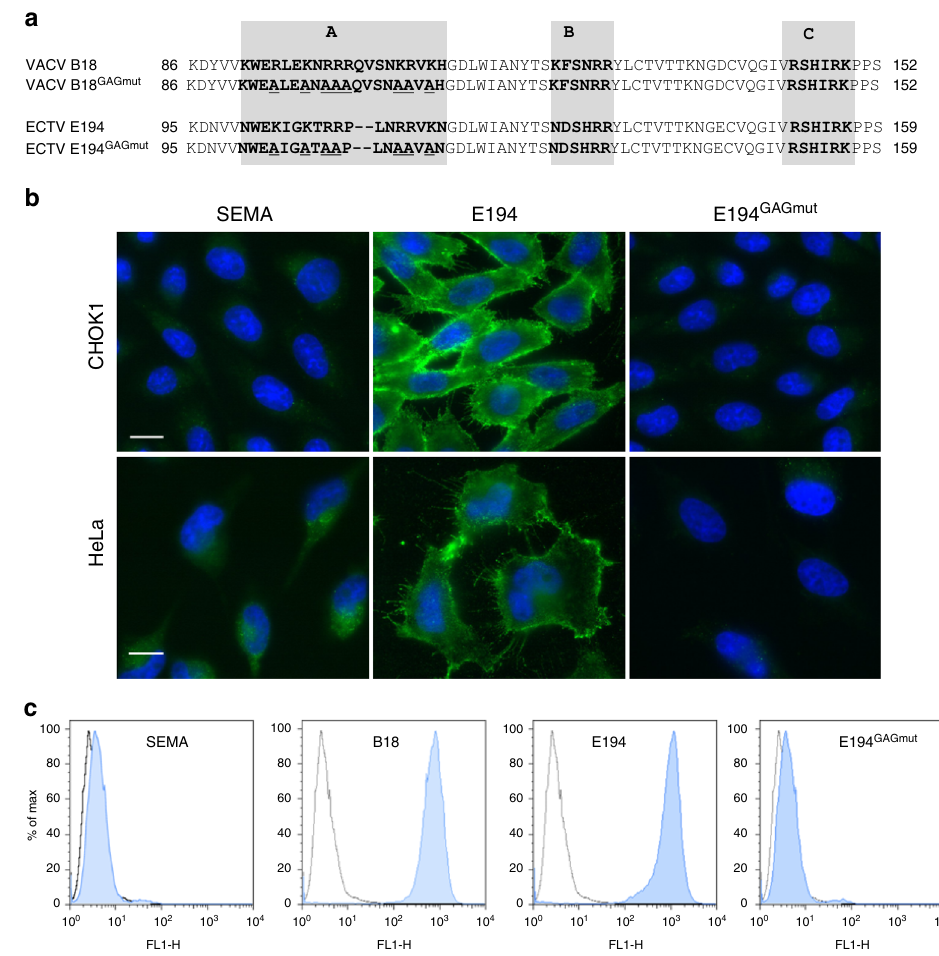
Fig. 1 Cell surface interaction of the IFN α / β BP from ECTV. a Partial amino acid sequence of the IFN α / β BP from VACV (B18) and ECTV (E194). Shaded boxes indicate the putative GAG binding regions A, B and C identi fi ed in the amino terminal sequence of the proteins. Amino acid substitutions of basic residues performed to generate their corresponding mutant proteins B18 GAGmut and E194 GAGmut are underlined. b The indicated cells were incubated at 4 °C for 30 min with V5-tagged recombinant proteins E194 and E194 GAGmut , and then extensively washed. Proteins were detected by immuno fl uorescence with an anti-V5 monoclonal antibody and cell nuclei were stained with DAPI. The unrelated viral protein SEMA was used as negative control. c CHOK1 cells were incubated with recombinant tagged proteins on ice and extensively washed, and the binding to cell surface was assessed by fl ow cytometry using an anti-V5 antibody. VACV B18 protein was incorporated as positive control. Shaded histograms correspond to the indicated protein while non-shaded correspond to untreated cells. In every case, experiments were performed in triplicate and a representative histogram is